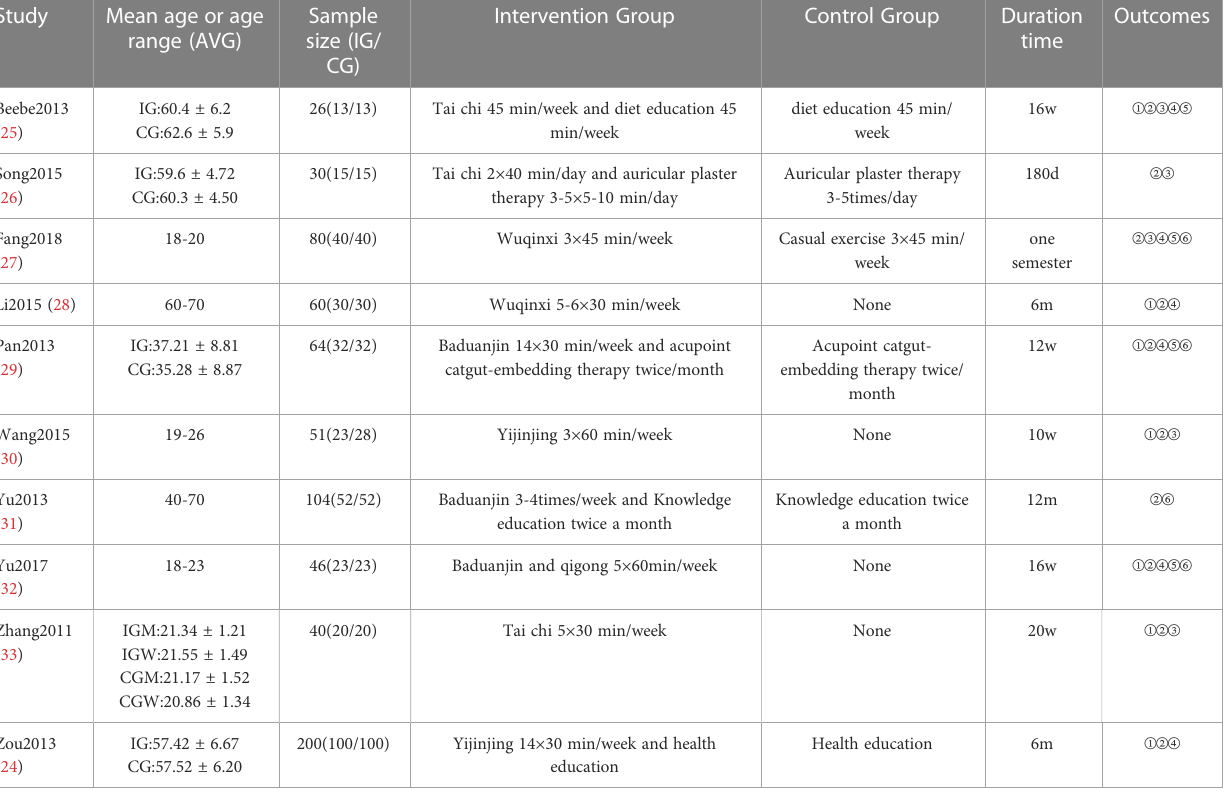
TABLE 2 Characteristics of the 10 studies included in the meta-analysis.